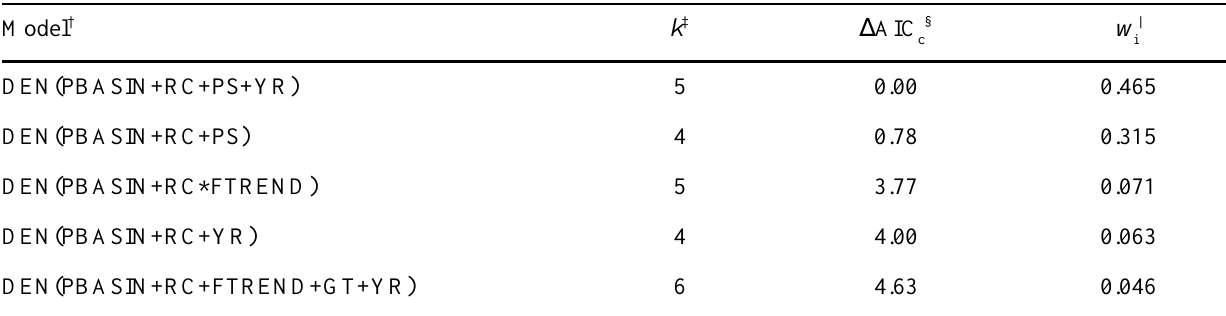
Table 1 . Rankings of duck nest density (DEN) models investigating effects of grass type (GT) and grazing co-variates, and year (YEAR). Grazing co-variates include residual cover (RC), residual cover field trend (FTREND), and pasture score (PS). All models contain a co-variate to control for field-specific water conditions (proportion of flooded basins or PBASIN). Models are generalized linear models with a negative binomial error distribution ( n = 100 fields). Only models within the 95% confidence interval group of models, i.e., S w = 0.95, are presented (Burnham and Anderson 1998). i Model † k ‡ D AIC c§ w i| DEN(PBASIN+RC+PS+YR) 5 0.00 0.465 DEN(PBASIN+RC+PS) 4 0.78 0.315 DEN(PBASIN+RC*FTREND) 5 3.77 0.071 DEN(PBASIN+RC+YR) 4 4.00 0.063 DEN(PBASIN+RC+FTREND+GT+YR) 6 4.63 0.046 † Models including interaction terms include all main effects. ‡ Number of estimated parameters.